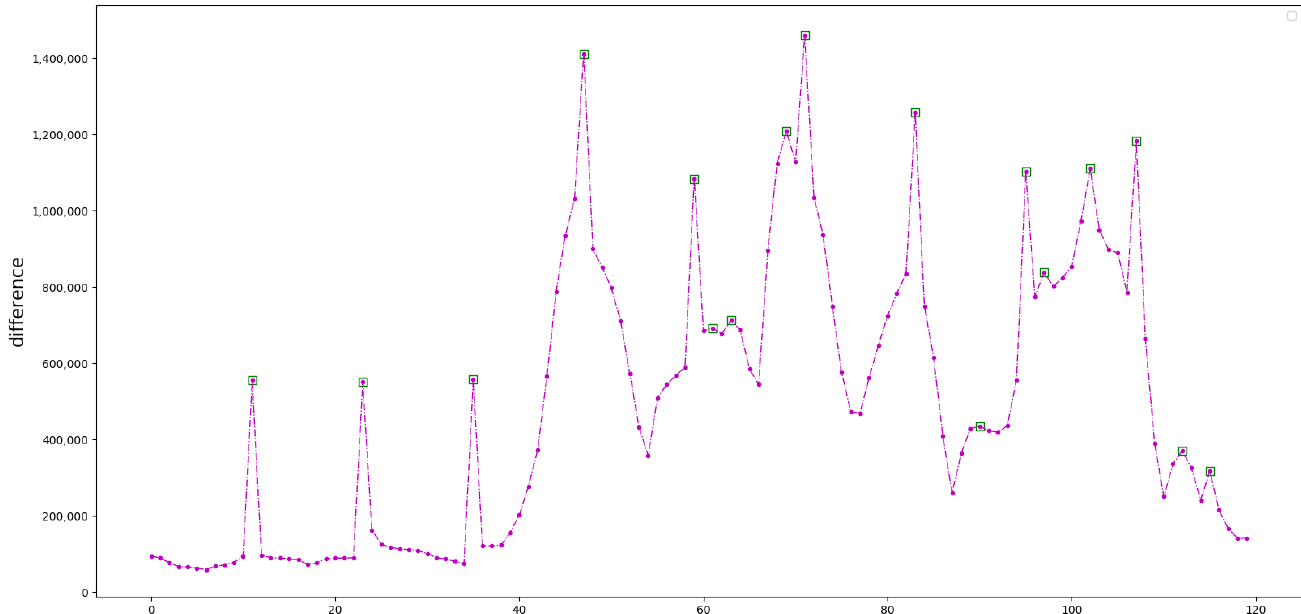
Figure 8. The output of Inter-frame difference method. The purple dots are the differences between two adjacent frames, and the green rectangle boxes are local extremes. The horizontal axis is the number of frames, and the vertical axis is the difference value between frames.